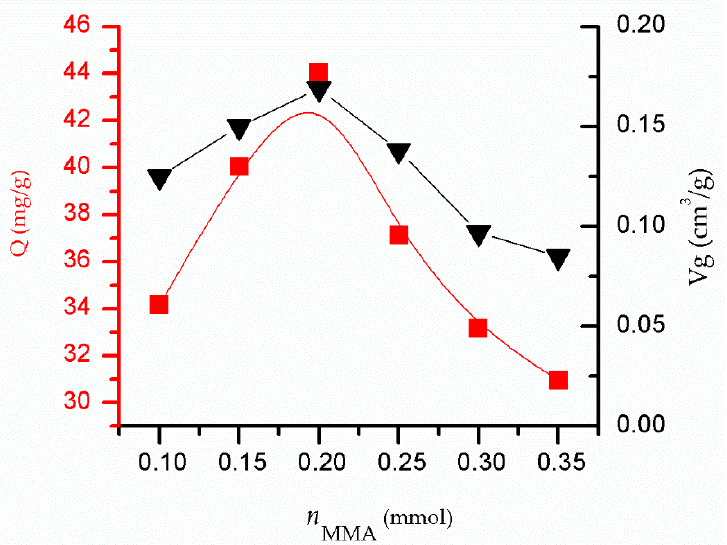
Figure 6. The influence of n MMA on the adsorption performance of MIPs and pore volume.